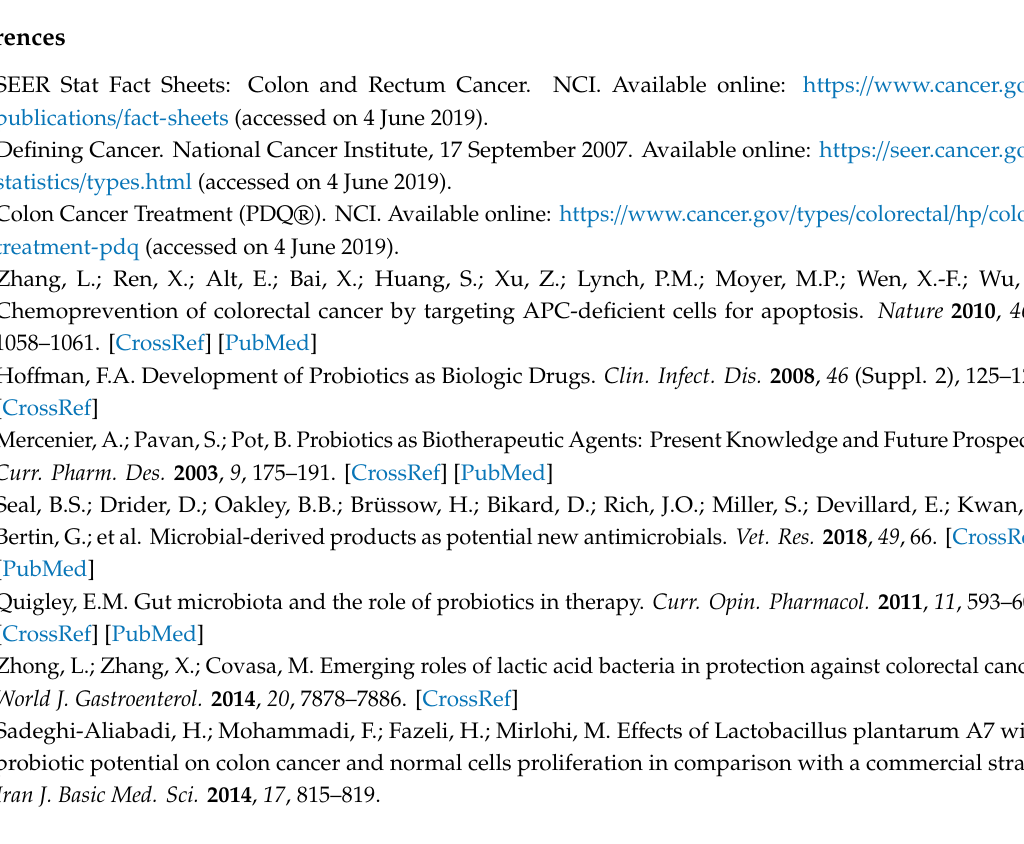
Figure S1: Verification of no cytoplasmic contamination in the isolated nuclear fraction, Figure S2: Apoptotic property of exogenous r-p8